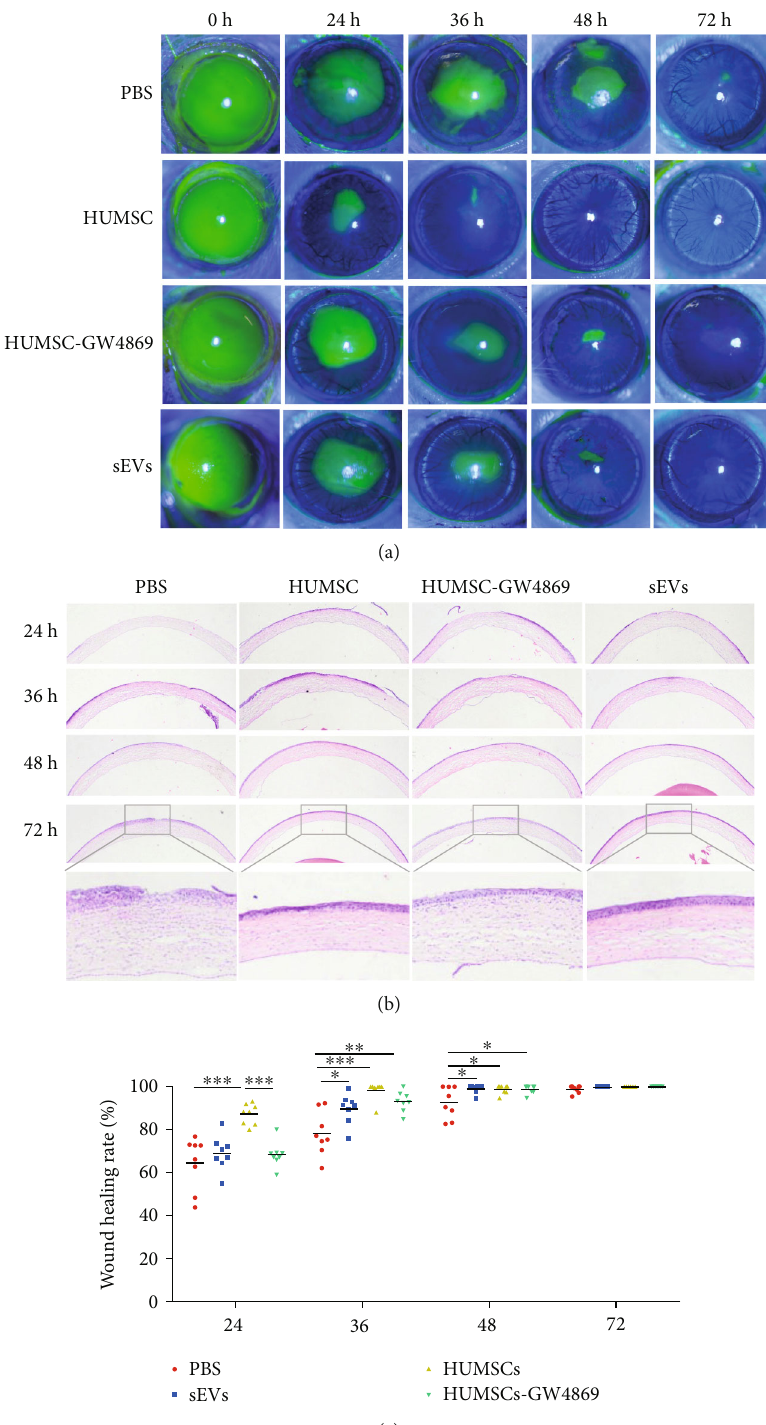
Figure 2: The e ff ect of HUMSCs and HUMSC-sEVs on corneal epithelial wound healing in vivo. (a, c) Fluorescein-stained images of defect corneas, before and after treatment with HUMSCs, HUMSCs-GW4869, HUMSC-sEVs, or PBS. (b) H&E staining showed the histologic appearance of the cornea. Data are expressed as the means ± SD . ∗ P < 0 : 05 , ∗∗ P < 0 : 01 , and ∗∗∗ P < 0 : 001 , n = 8